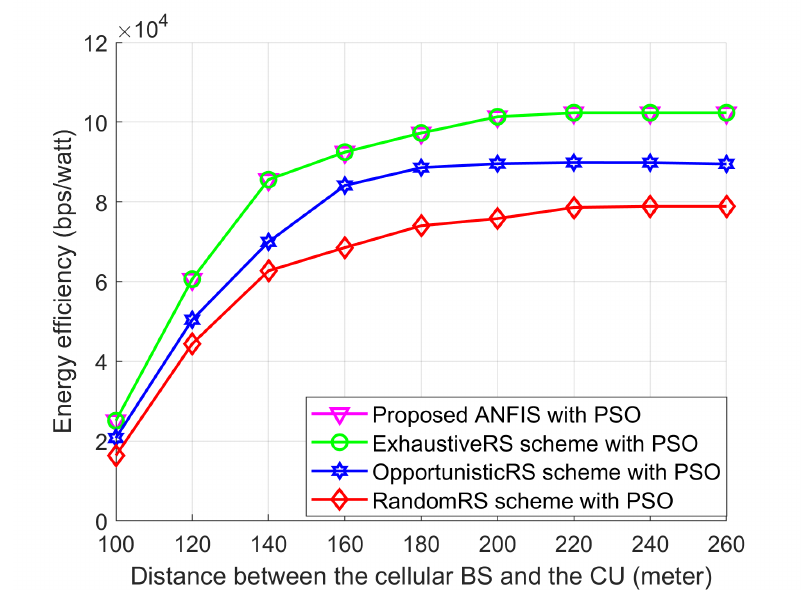
Figure 13. Effect of the relay-selection schemes on energy efficiency according to the distance between the cellular BS and the CU when the proposed PSO is used in all relay-selection